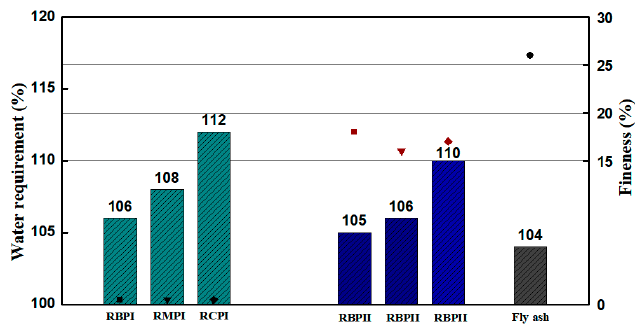
Figure 10. The WRR and fineness of RP.